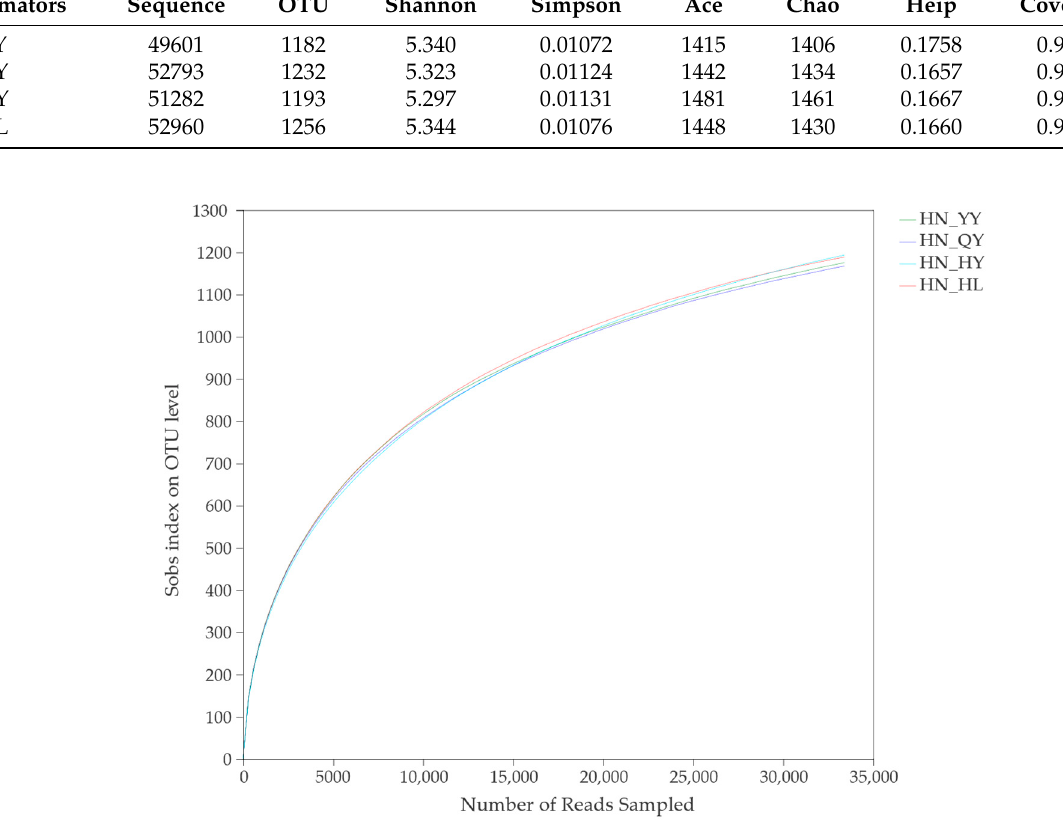
Figure 1. Rarefaction curves of OTUs clustered at 97% sequence identity across in the anaerobic sludge (HN_YY), anoxic sludge (HN_QY), aerobic sludge (HN_HY), and return sludge (HN_HL). Table 2. Sequence, OTUs, coverage, and Alpha diversity of microbial communities in the anaerobic sludge (HN_YY), anoxic sludge (HN_QY), aerobic sludge (HN_HY), and return sludge (HN_HL).